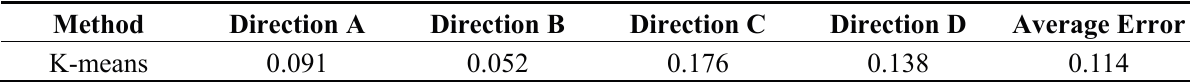
Table 6. Results from performing banknote recognition after pre-classifying the banknote’s direction (unit: %).